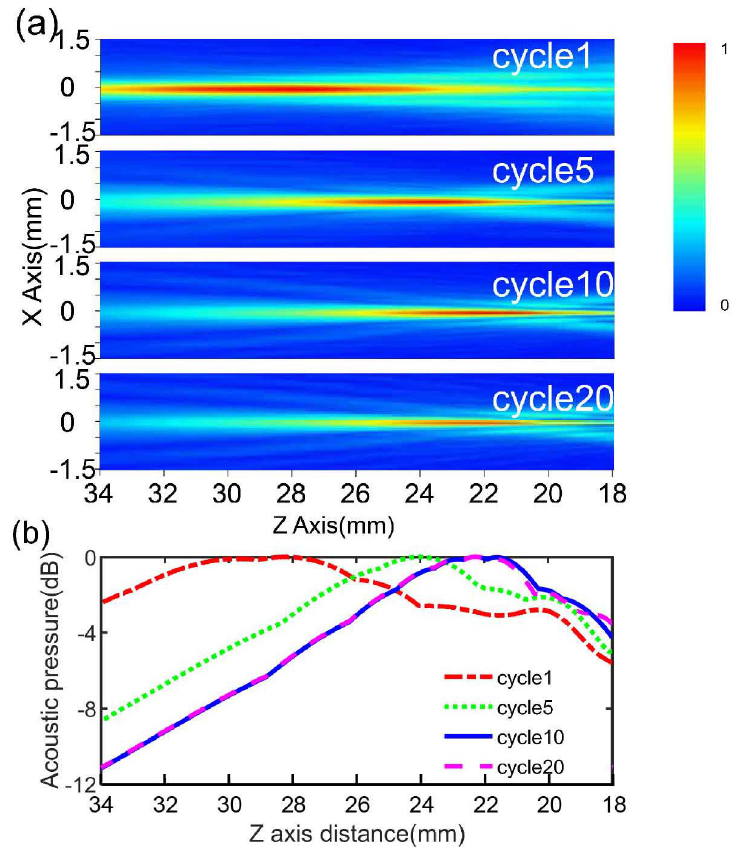
Figure 3. ( a ) Focal depth determined from acoustic pressure patterns and ( b ) acoustic pressure along the Z axis under different cycle numbers, by PZFlex simulation.